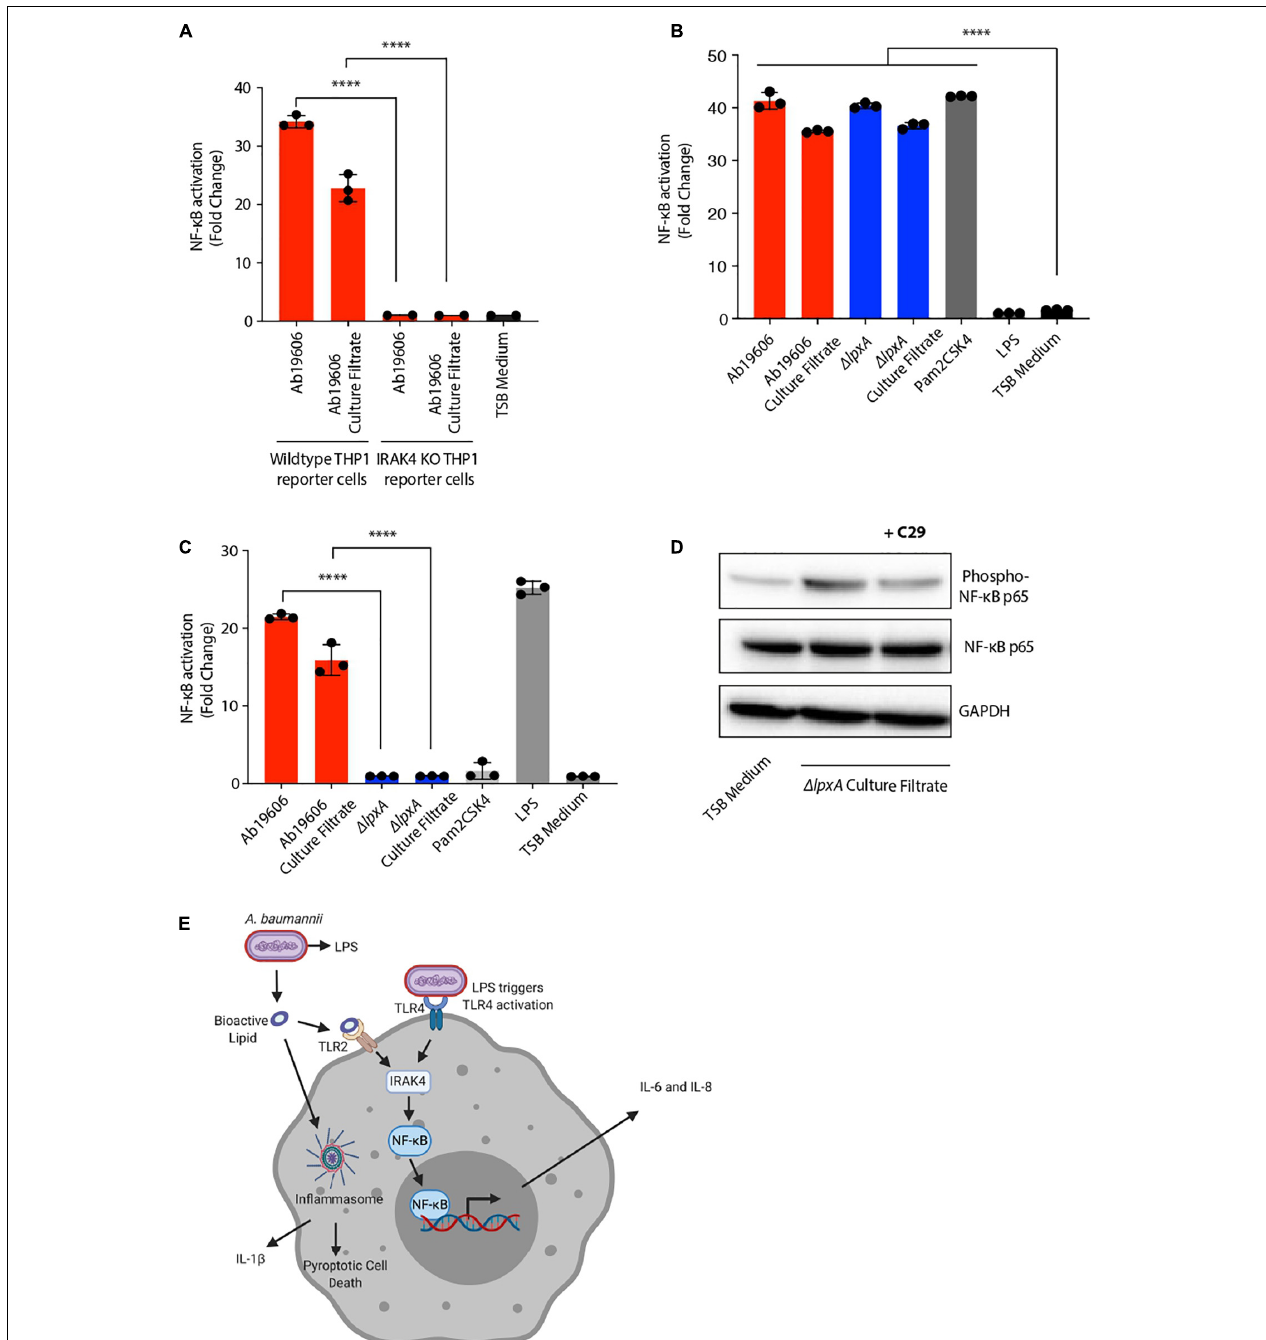
FIGURE 5 | Acinetobacter baumannii secretes a TLR2 activating lipid that triggers canonical NF- κ B signaling. (A) Wildtype THP1-XBlue reporter cells or THP1-XBlue IRAK4 − / - reporter cells were infected with wildtype A. baumannii (Ab19606) or treated its culture filtrate. TSB medium was used to grow the bacterial cultures and fresh TSB medium treatment served as the negative control. Levels of SEAP were assessed after 24 h from the beginning of the treatment. The experiments were done in triplicates. Error bars represent standard deviation. One-way ANOVA with Tukey’s multiple comparisons test. (B,C) HEK293 reporter cells stably expressing TLR2 (B) or TLR4 (C) were infected with wildtype A. baumannii (Ab19606) or (cid:49) lpxA at MOI 10 or were treated with the respective culture filtrates. Levels of SEAP were assessed after 24 h of infection or culture filtrate treatment. TSB medium was used to grow the bacterial cultures and fresh TSB medium treatment served as the negative control. Pam2CSK4 and LPS served as additional controls. The experiments were done in triplicates. Error bars represent standard deviation. One-way ANOVA with Tukey’s multiple comparisons test. (D) THP1 macrophages treated with or without the TLR2 inhibitor C29 were exposed to (cid:49) lpxA culture filtrate. Western blot was performed to check the phosphorylation of NF- κ B p65. (E) Schematic representation depicting the secretion of the bioactive lipid by A. baumannii that activates inflammatory signaling (created with BioRender.com). All the experiments were performed three times independently. * P < 0.05, ** P < 0.01, *** P < 0.001, **** P <